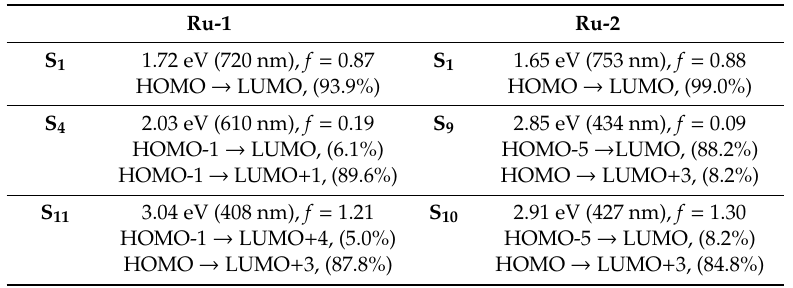
Table 1. Transition energy (wavelength), oscillator strength f , and the dominant electronic configuration (orbital contribution) of selected excited states of Ru-1 and Ru-2 calculated at the B3LYP/6-31G(d) (lanl2DZ for Ru) level in vacuum. The information including the other excited states are summarized in Table S1 in Supplementary Materials.